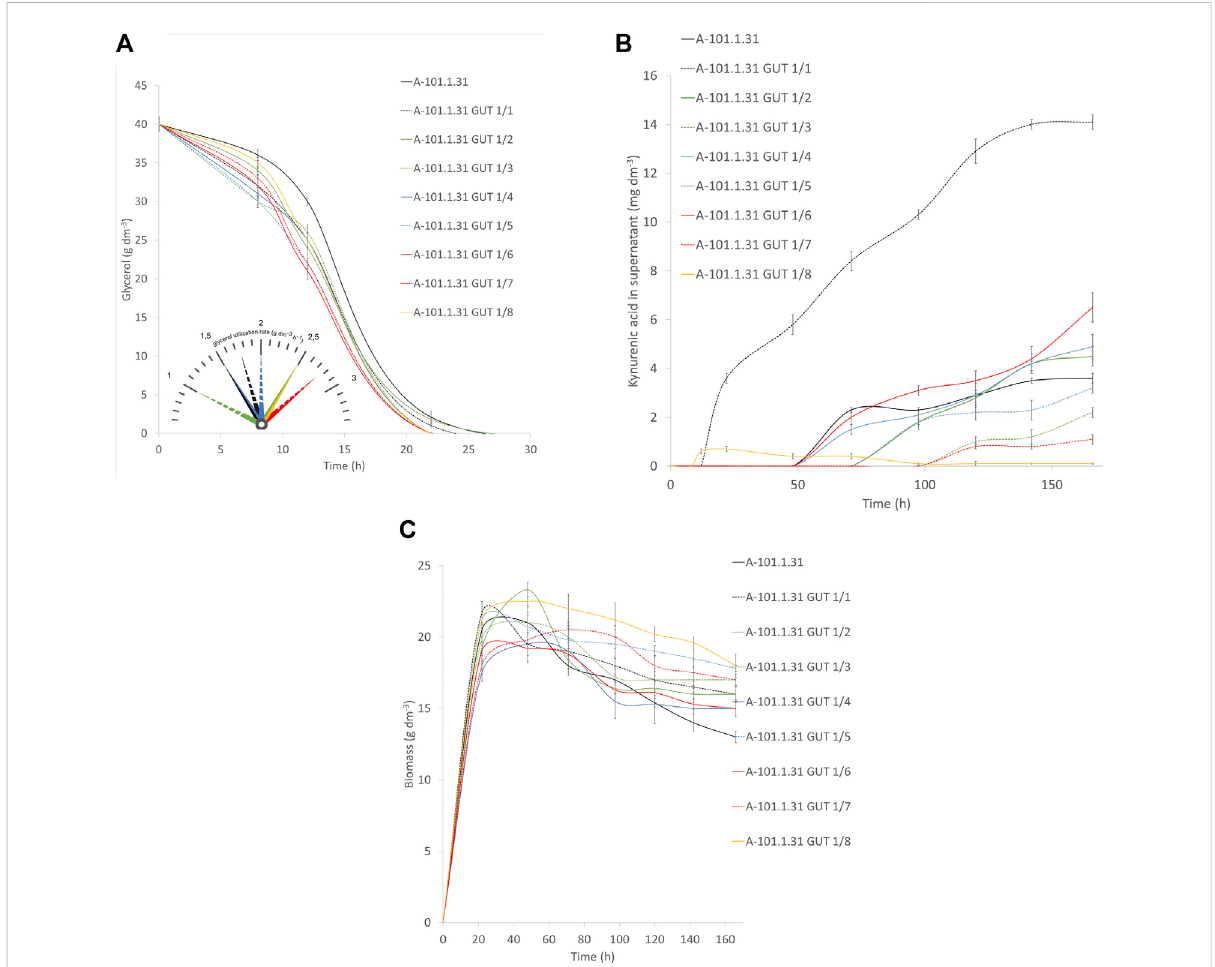
FIGURE 2 Waste glycerol utilization (A) and kynurenic acid (B) and biomass (C) production during batch bioreactor cultures of the Y. lipolytica A- 101.1.31 strain and mutant strains of Y. lipolytica (A-101.1.31 GUT 1/1 — A-101.1.31 GUT1/8) overexpressing glycerol kinase. In the Panel A, the glycerol utilization rate for mutants is presented in the time between 8 and 12